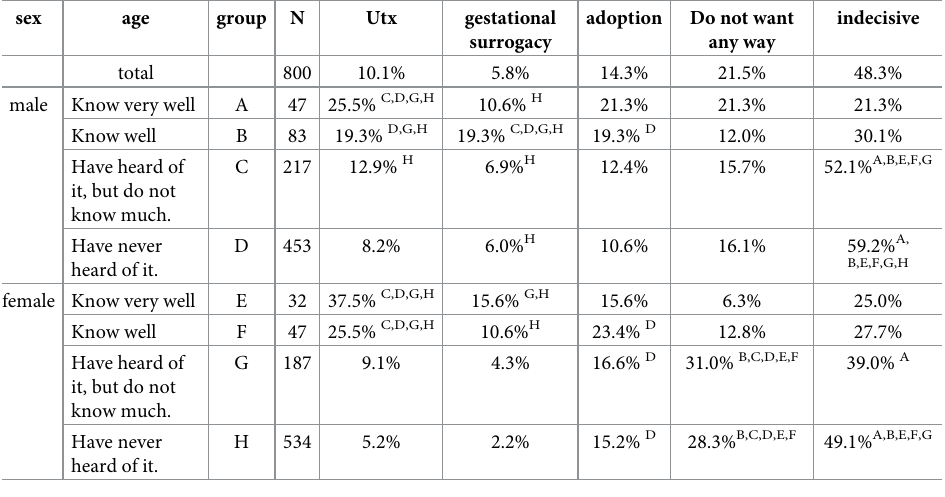
Table 11. Attitudes towards each UTx, gestational surrogacy, and adoption assuming that the respondents or their spouse are suffer from absolute uterine factor